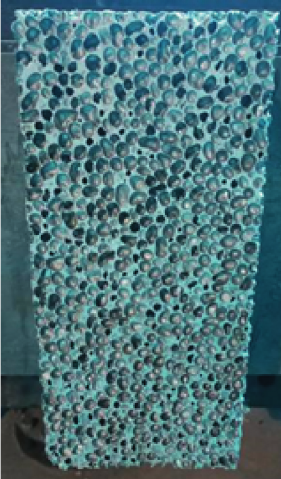
Figure 2: Closed-cell aluminum foam material.